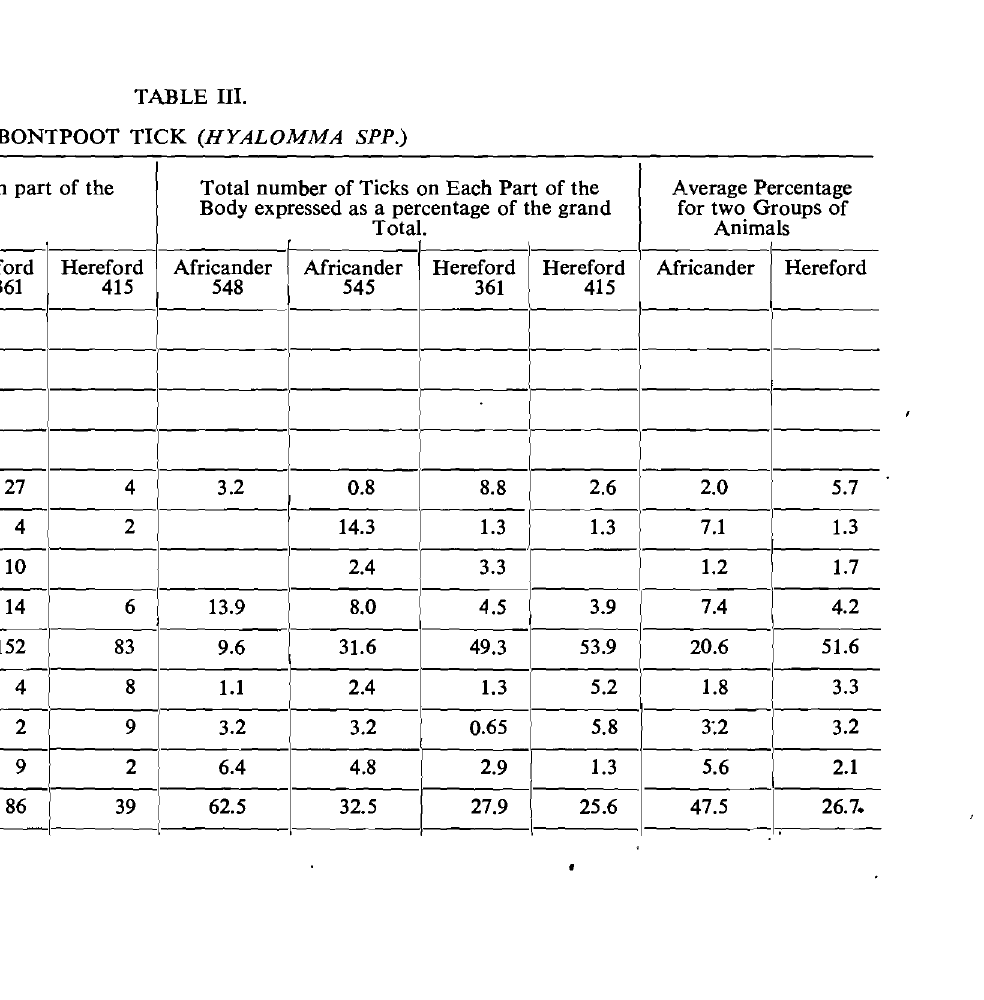
BONTPOOT TICK (HYALOMMA SPP.) Parts of the body Total number of ticks for each part of the Total number of Ticks on Each Part of the Average Percentage Body Body expressed as a percentage of the grand for two Groups of